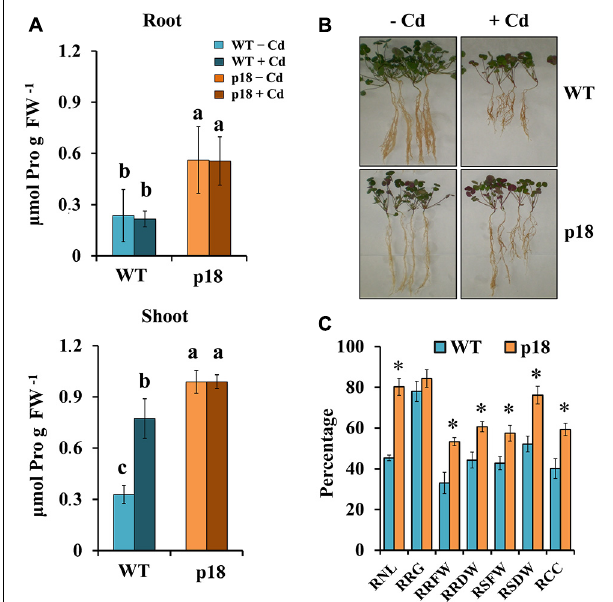
FIGURE 4 | Effects of cadmium treatment on M. truncatula WT and transgenic p18 plants after 32 days of growth in pots in the presence of 0 or 100 µ M CdCl 2 . (A) Pro content in roots (upper panel) and shoots (lower panel). Different letters denote significant differences between lines and treatments in roots or shoots, Tukey HSD, p < 0.05, n = 4. (B) Representative image of M. truncatula WT and p18 plants grown for 32 days in the absence or presence of 100 µ M CdCl 2 . (C) Relative growth parameters of Cd-treated M. truncatula WT and p18 plants calculated as percentages of the values recorded for plants grown in the absence of Cd. Bars indicate standard error. ∗ Indicates significant differences between genotypes (ANOVA, p < 0.05, n = 10). RNL, relative number of leaves; RRG, relative root growth; RRFW, relative root fresh weight; RRDW, relative root dry weight; RSFW, relative shoot